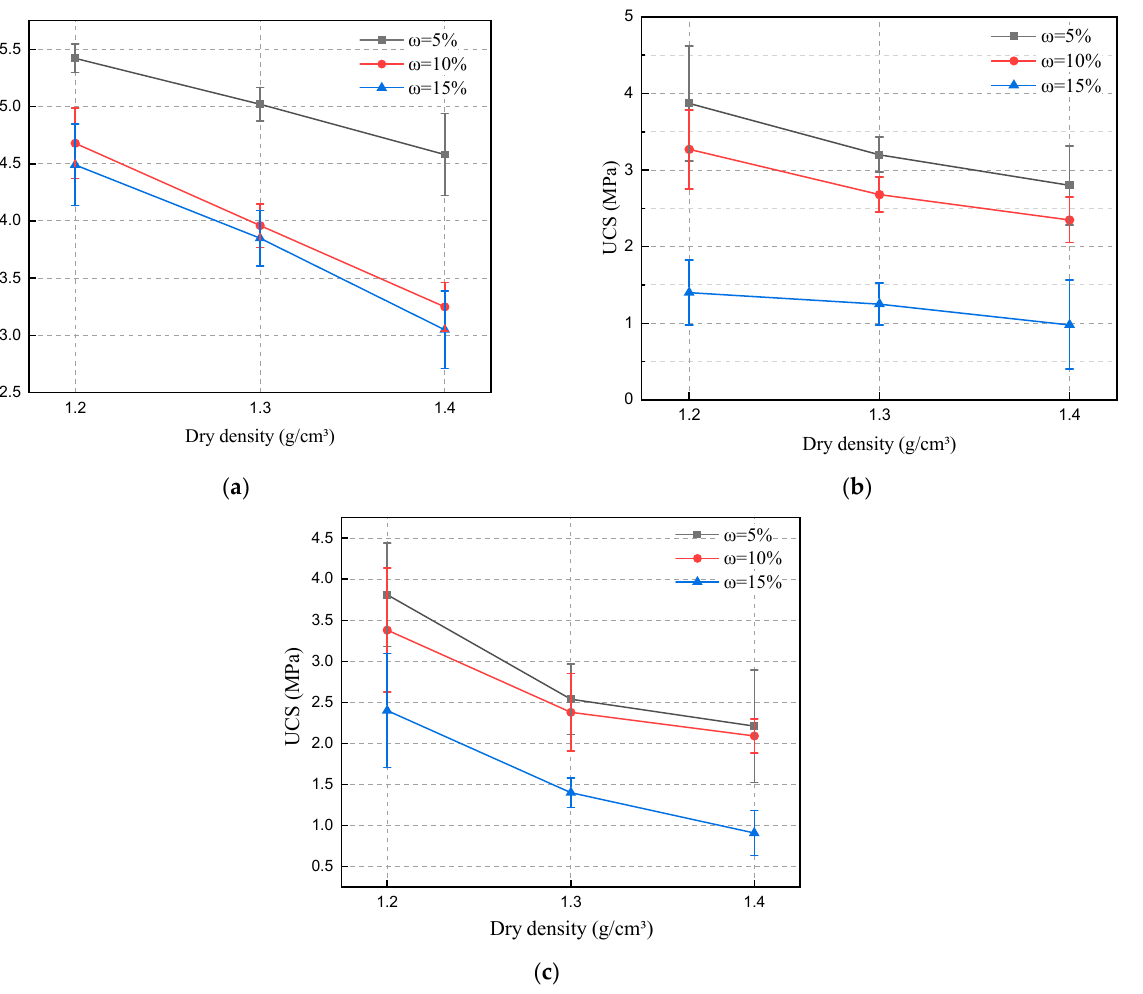
Figure 6. The effect of dry density and water content on compressive strength. ( a ) SL without soaking, ( b ) SL soaked in water, ( c ) SL soaked in salt solution.